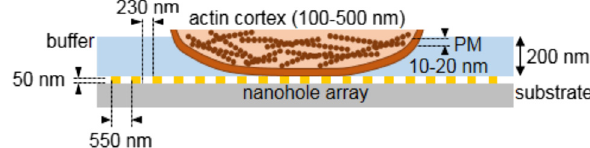
Figure 2: Scheme of the nanohole array configuration. Sensing chips are 50 nm thick gold fi lms (99.999%) deposited on a glass slide coated with a 3 nm Ti fi lm. The nanostructures are square periodic arrays of circular nanoholes. The period is 550 nm and the nanohole average diameter is 230 nm which are standard parameters to give a sensitivity of the order of 400 nm/RIU for a wavelength of 750 nm for the maximum transmitted intensity at the is about 200 nm. The part of the cell that penetrates into the surface plasmon includes the plasma membrane (PM) (10 – 20 nm) and the actin cortex (100 – 500